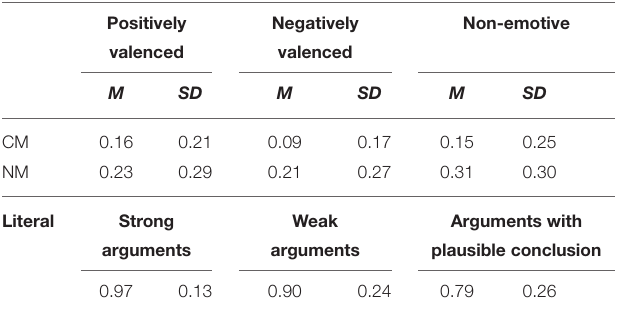
TABLE 2 | Mean (M) and standard deviation (SD) values of correct answers for each middle term condition (Experiment